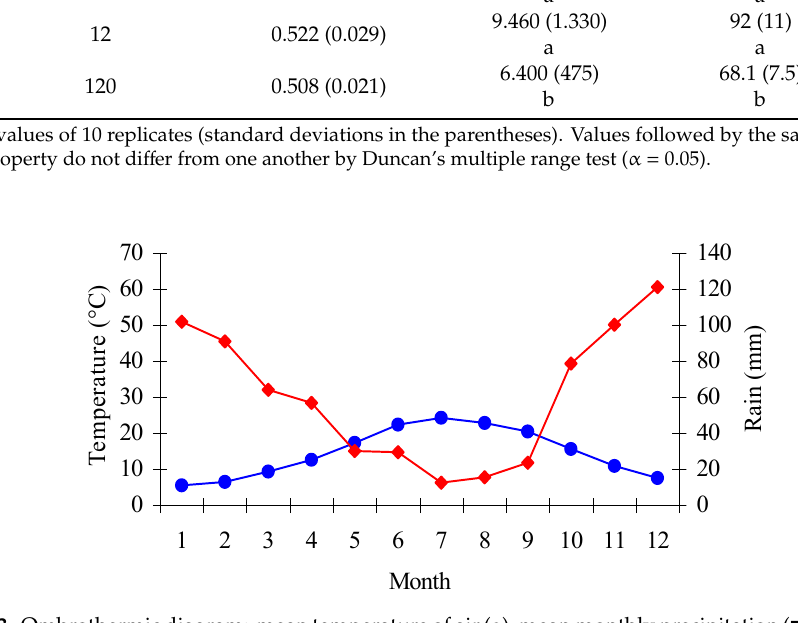
Figure 3. Ombrothermic diagram: mean temperature of air ( • ), mean monthly precipitation ( (cid:4) ). The period in which the mean monthly precipitation is below the mean temperature of air denotes the dry